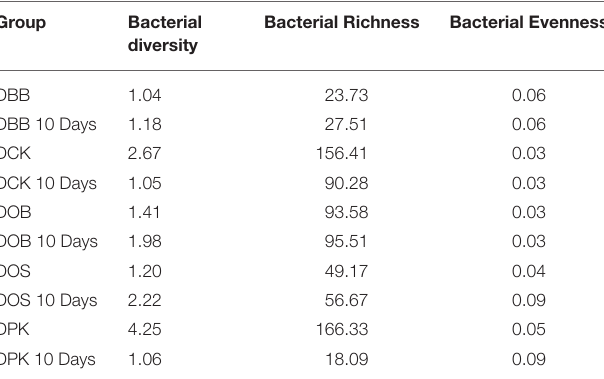
TABLE 1 | Bacterial diversity, bacterial richness and bacterial evenness of the five starters and the microbial communities after 10 days of fermentation. Group Bacterial Bacterial Richness Bacterial diversity